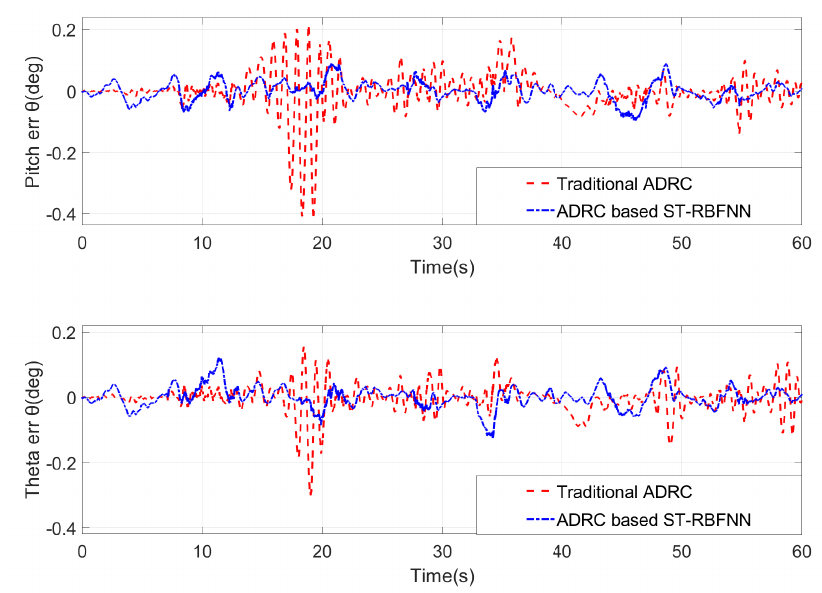
Figure 11. Flight attitude tracking error when external interference occurred in Scenario 2.